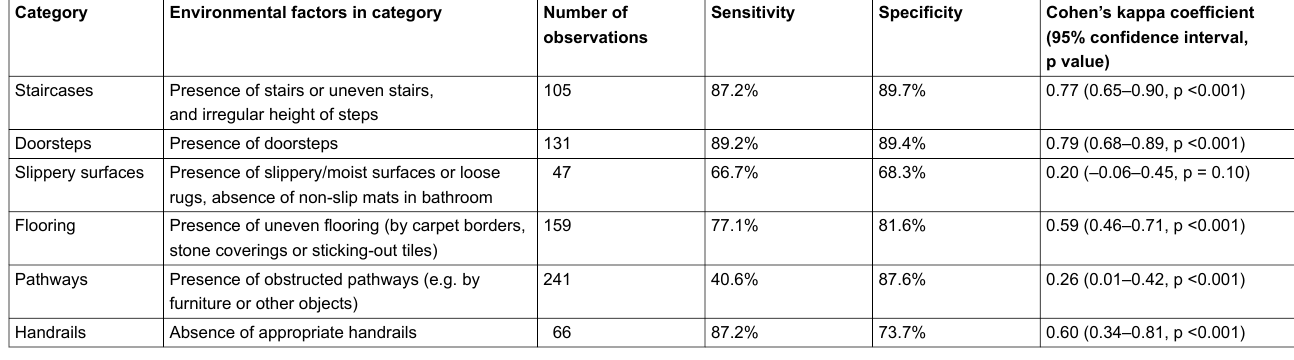
Table 3: Pearson’s and intraclass correlation coefficients of the photography-based home assessment for the continuous scores in each category compared with the gold standard (on-site home assessment). Category Environmental factors in category Number of Measurement of numbers and dimensions of steps Doors Measurement of threshold/doorstep heights Measurement of parking place width Measurement of seat and bed heights Measurement of toilet